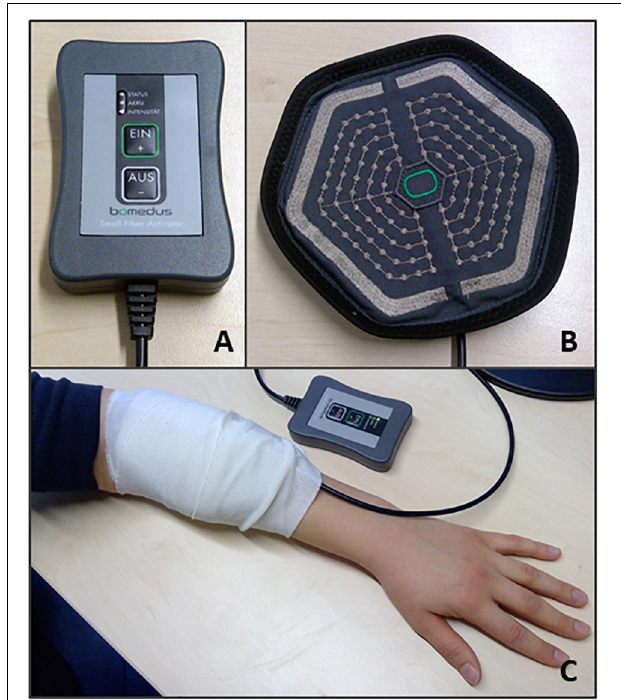
FIGURE 2 | PEMS set up. The following equipment was used to deliver the PEMS for both experiments: (A) The PEMS stimulator (The Small Fiber Activator; Bomedus GmbH); (B) A circular matrix electrode (Bomedus GmbH). (C) Shows the placement of the matrix electrode on the left forearm. A bandage was wrapped around the electrode to ensure optimal contact between the electrode and the